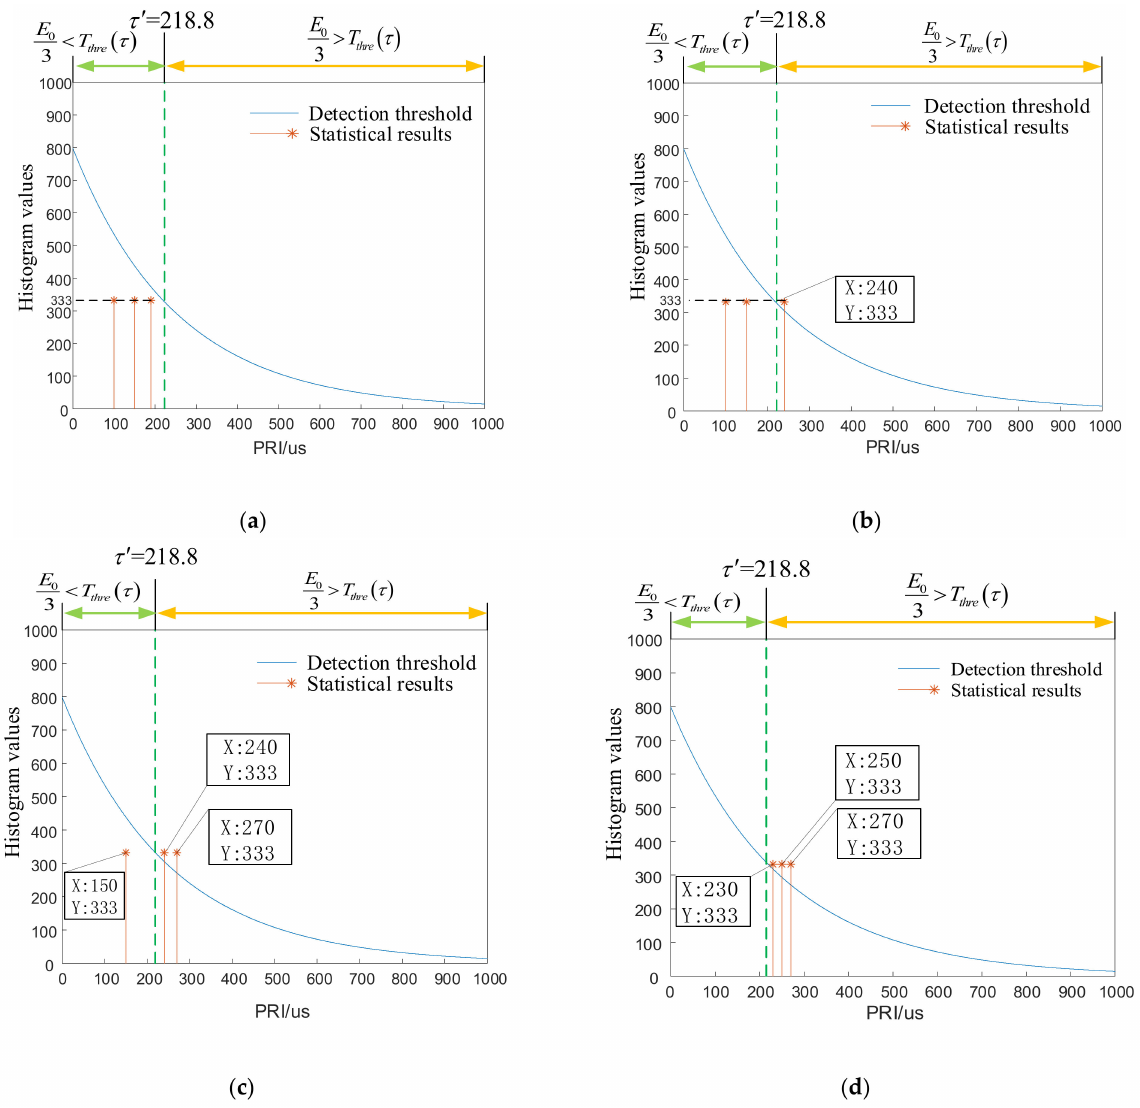
Figure 5. Histogram of first-order TOA difference in simulation case 3. ( a ) The PRI values of the three signals all less than the sorting failure critical condition; ( b ) a signal whose PRI value is larger than the sorting failure critical condition; ( c ) two signals whose PRI values are larger than the sorting failure critical condition; ( d ) the PRI values of three signals larger than the sorting failure critical